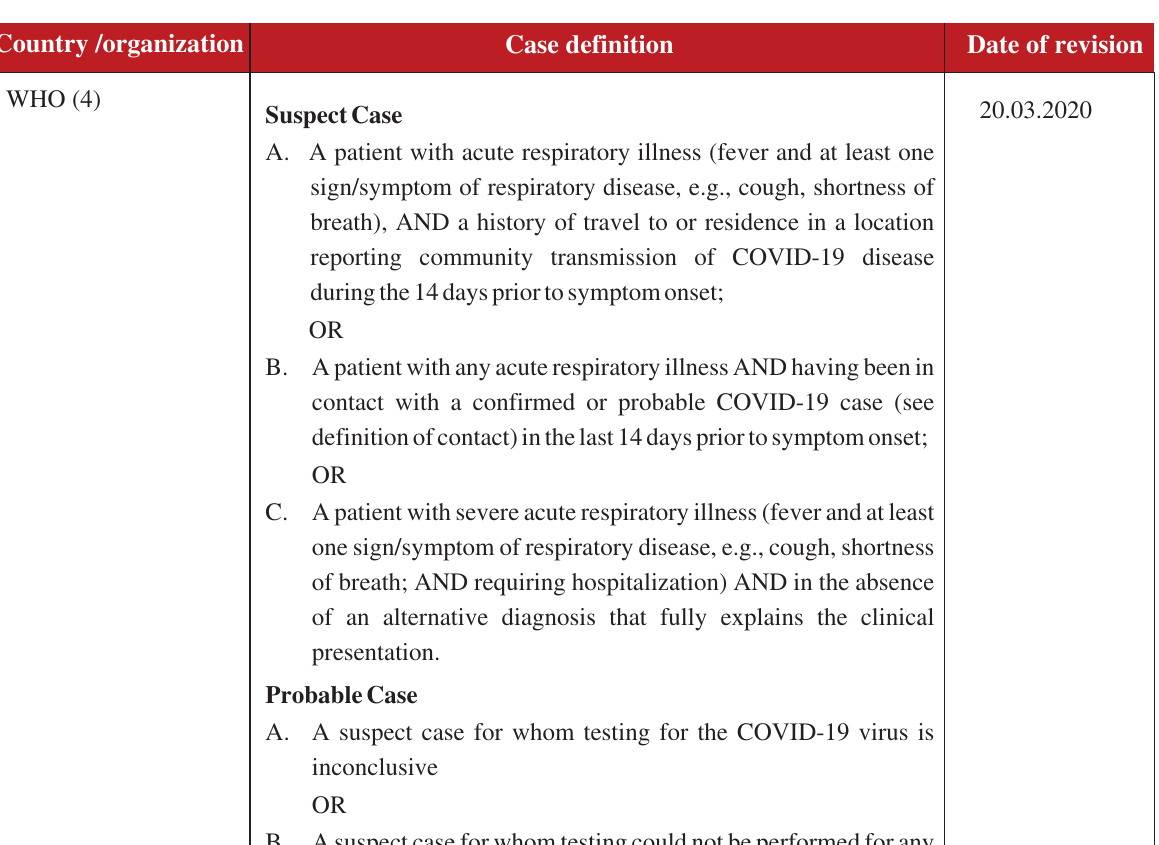
Table 1: Case definitions for COVID-19 across countries/organizations Country